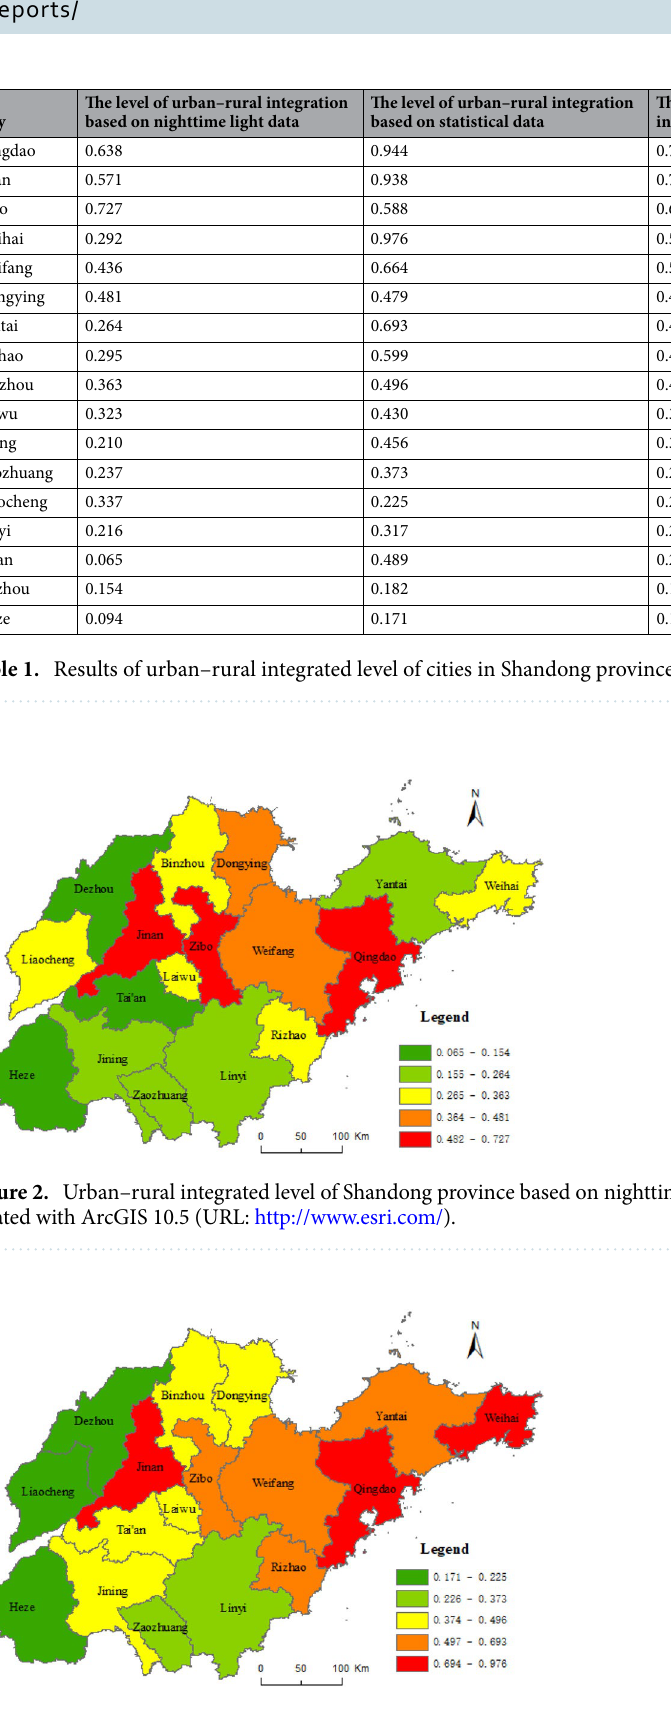
Figure 3. Urban–rural integrated level of Shandong province based on statistical data. This figure was created with ArcGIS 10.5 (URL: http:// www. esri.